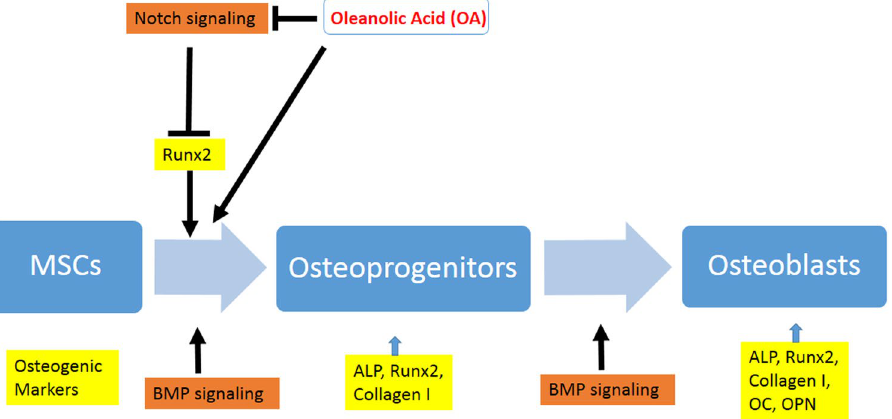
Figure 5. Possible model of OA in regulation of MSC osteogenic differentiation. Inhibition of Notch signaling by OA in MSC culture stimulates osteogenic gene expression (ALP, Runx2, Collagen I) that may lead to enhanced MSC osteogenic differentiation in the early stage of osteoblast formation. OA works parallel with BMP signaling to accelerate MSC differentiation toward to